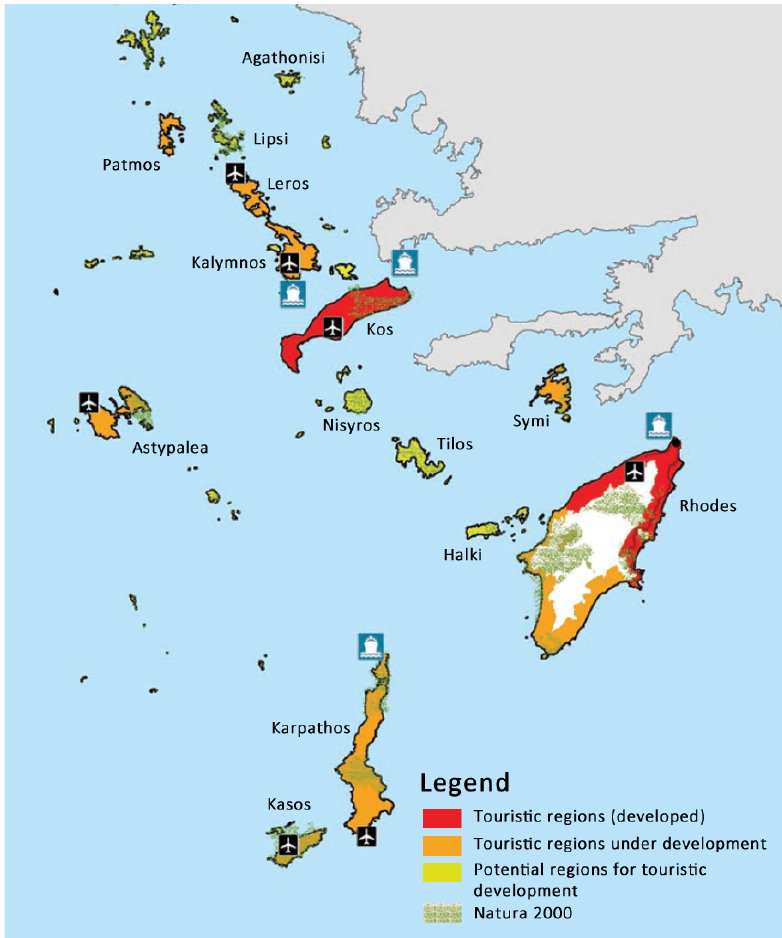
Figure 3. Spatial organization of tourism [50].